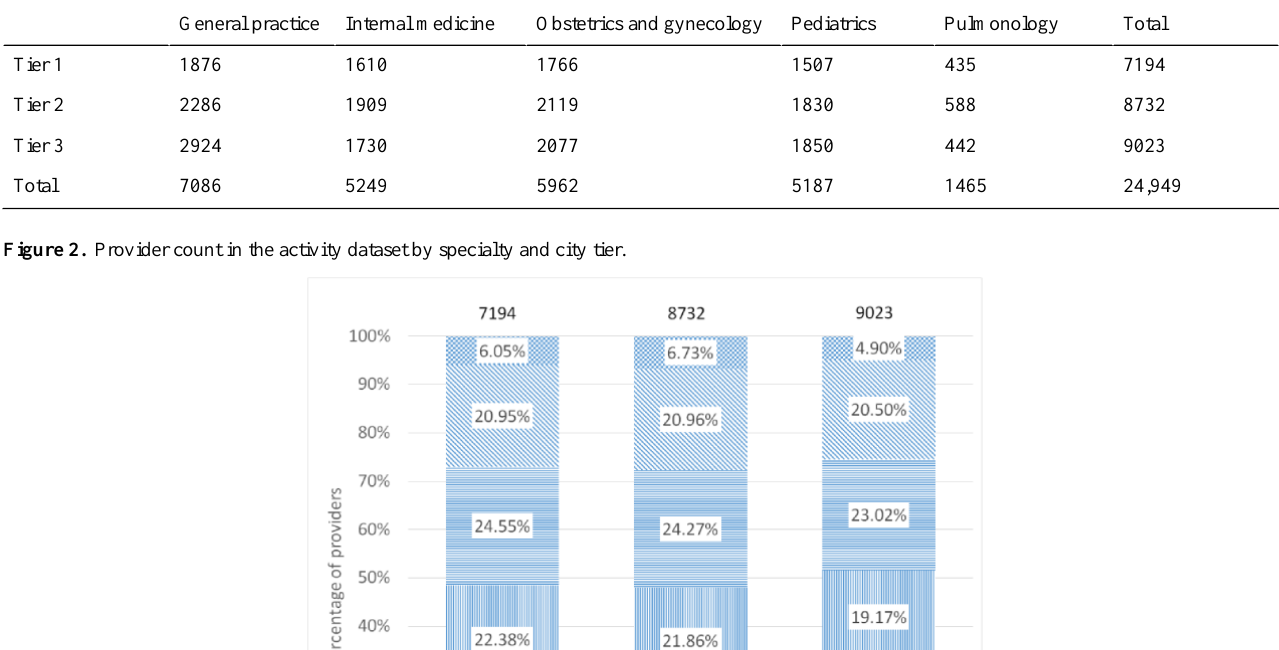
Table 3. Provider participation by city tier and specialty. Specialty, nCity tiers